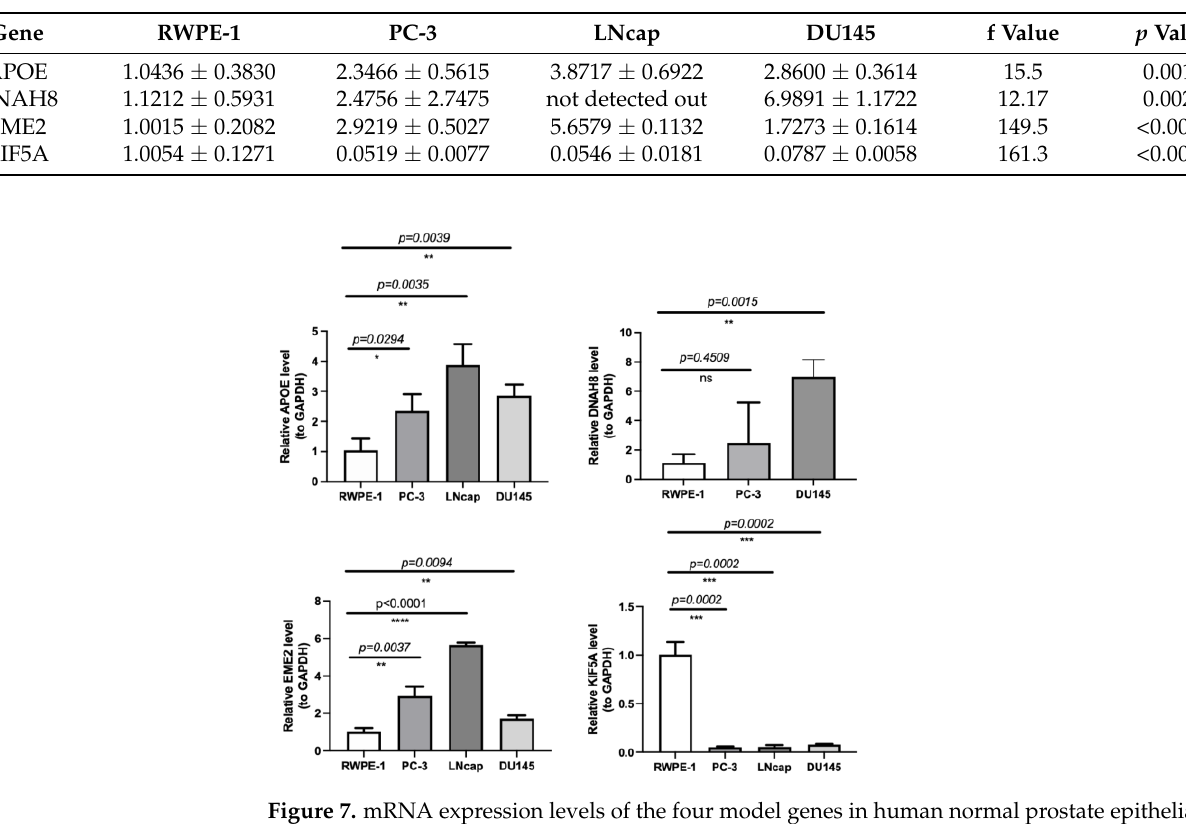
Table 6. qRT-PCR Results for the 4 model genes.